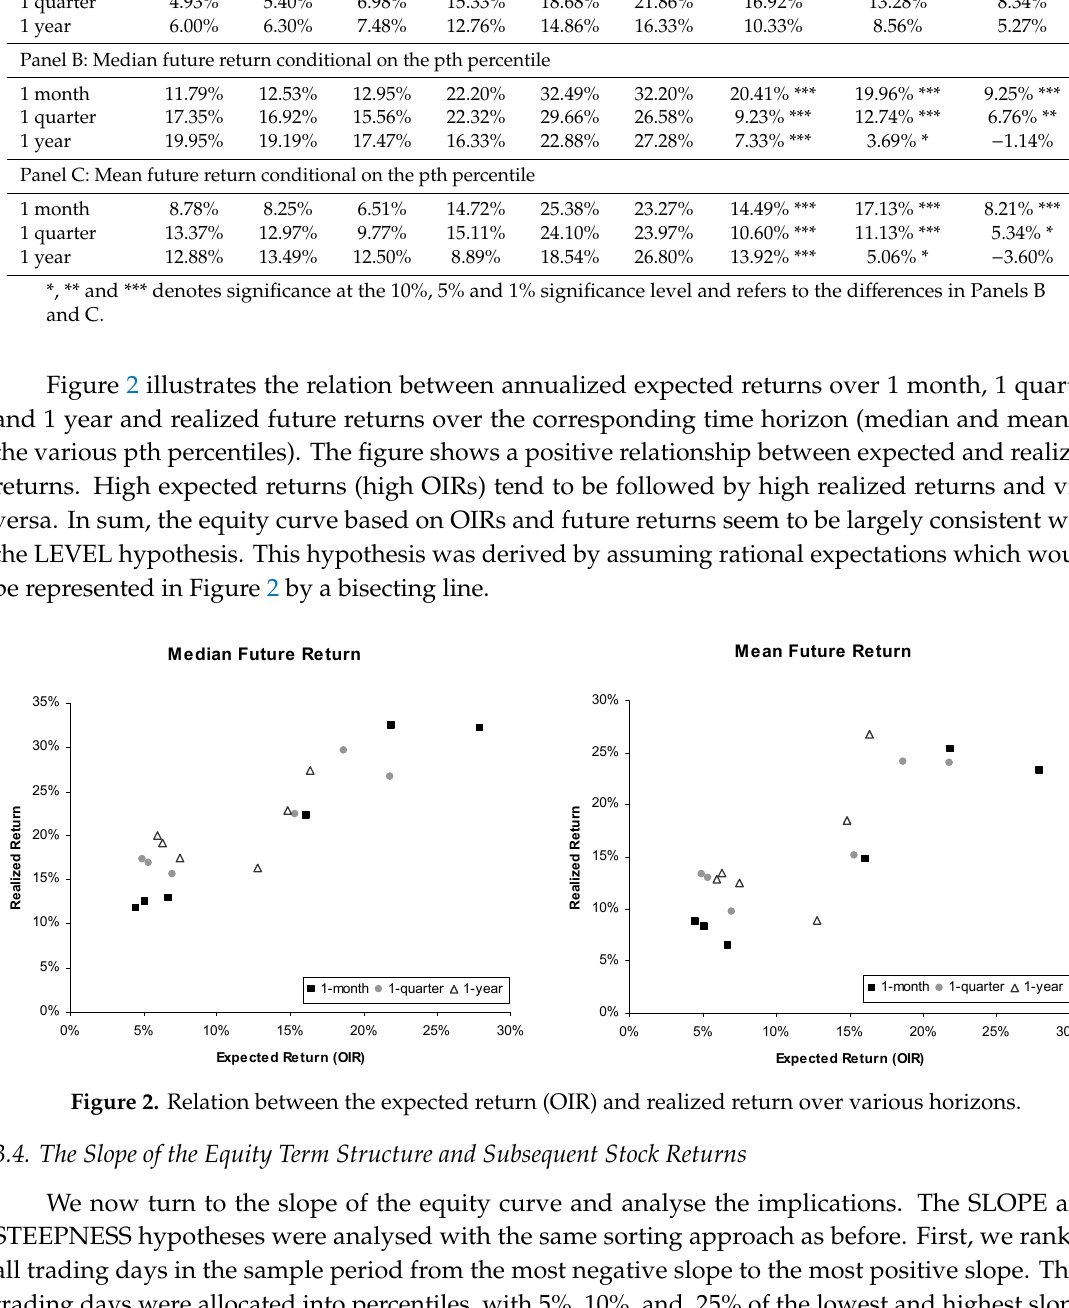
Table 2. Results from tests of the LEVEL hypothesis.